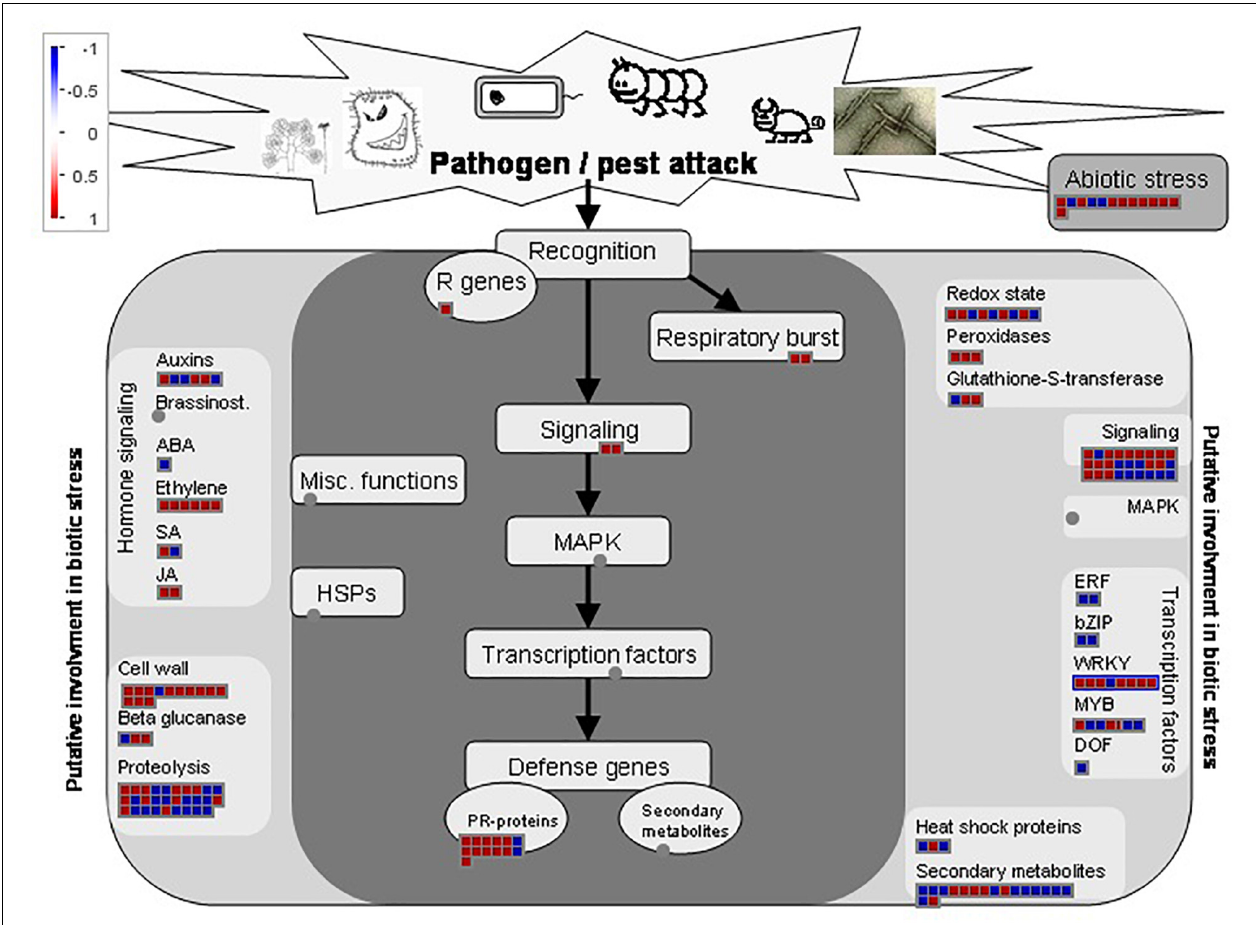
FIGURE 6 | Biotic stress overview pathway for BG11-inoculated plants DEGs as generated by MapMan software. Red and blue boxes represent up and downregulated genes, respectively. Colour intensity represents the degree of expression given as log 2 fold change > 1 and < –1.